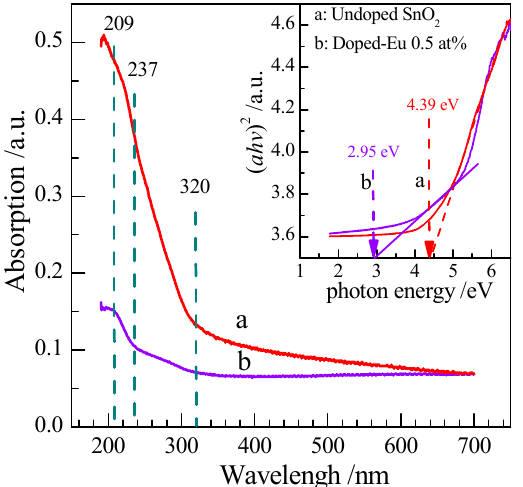
Figure 5. UV-vis spectra of undoped and 0.5 at % Eu-doped SnO 2 nanorods array.Inset: ( α h ν ) 2 vs. photon energy plots.